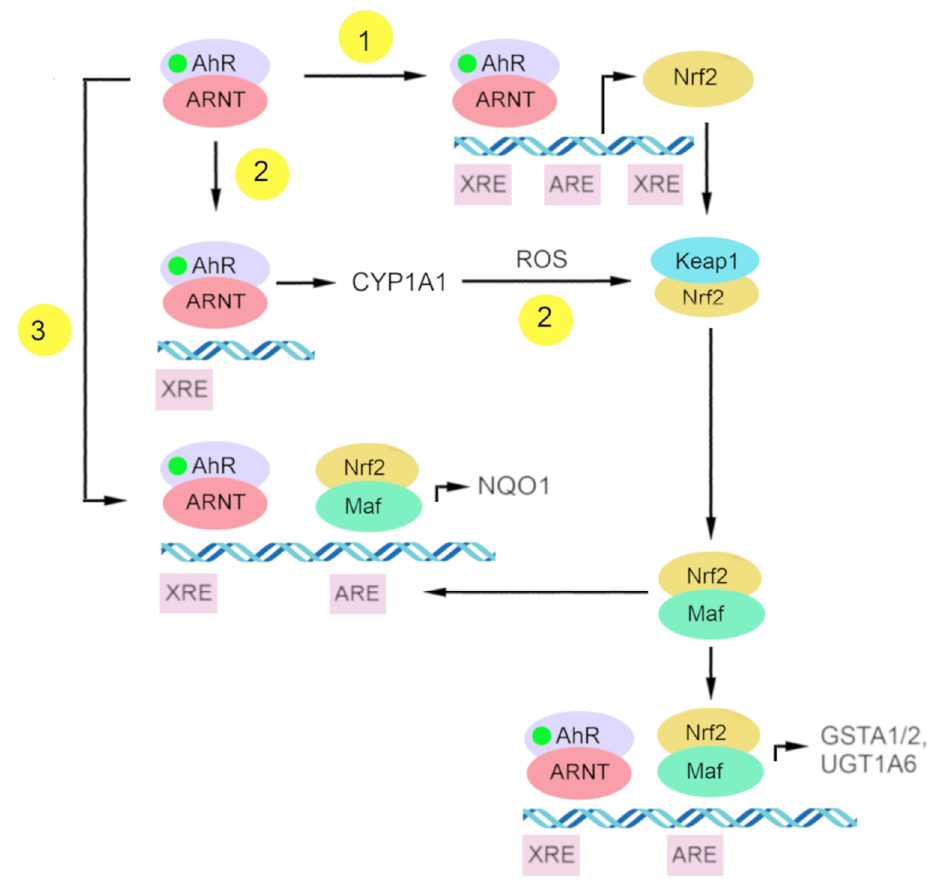
Figure 3. The scheme of putative connections between gene batteries of AhR and Nrf2. (1) Nrf2 is a target gene of AhR; (2) indirect activation of Nrf2 by CYP1A1-generated reactive oxygen species (ROS); and (3) direct interaction of complexes AhR–XRE and Nrf2–ARE in a regulatory region of the NQO1 gene.